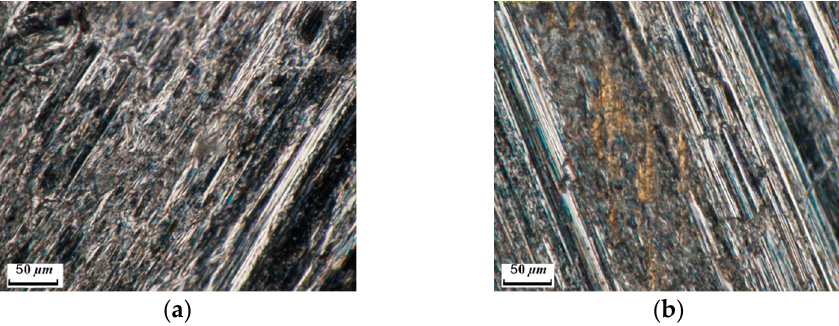
Figure 9. Wear tracks of the BT22 alloy: ( a ) untreated; ( b ) nitrided (light microscopy).